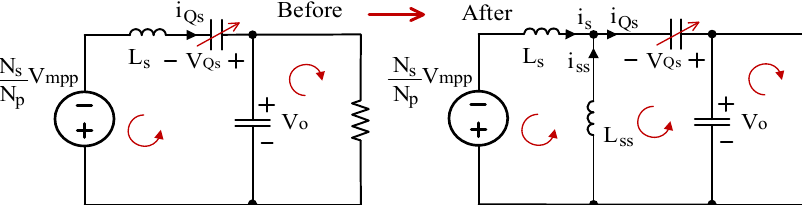
Energies 2022 , 15 , x FOR PEER REVIEW Figure 13. Without and with leakage bypass. Figure 13. Without and with leakage bypass.